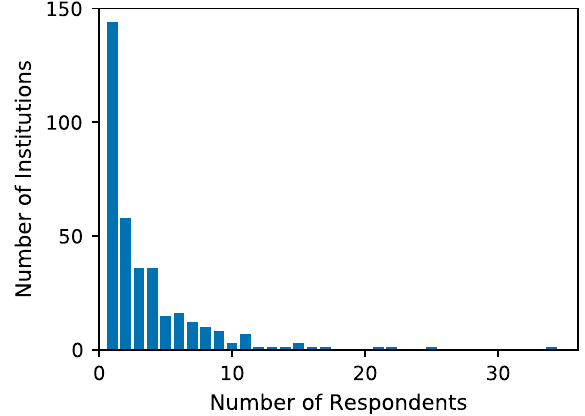
FIG. 1. The number of institutions with a given number of respondents is shown. 40% (144) of institutions had one faculty member respond to the survey while the remaining institutions (213) had more than one respondent including some institutions with more than 10 respondents and one with 35